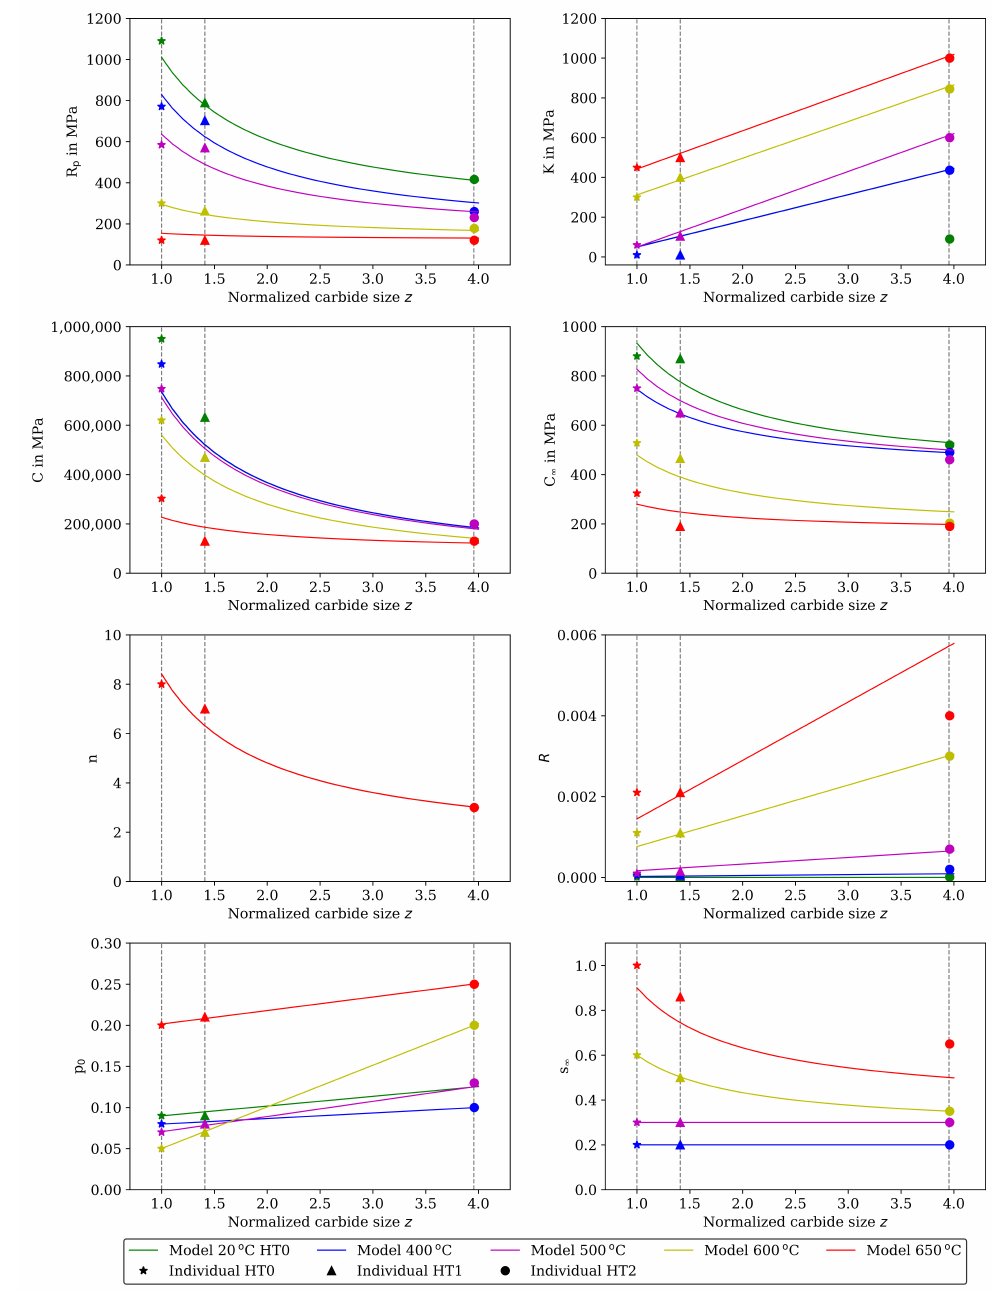
Figure 11. Material properties of the viscoplasticity model versus carbide size for different heat treatments, i.e., carbide sizes and temperatures. Individual determined material properties of step 1 are presented as symbol, functional dependencies of step 2 as